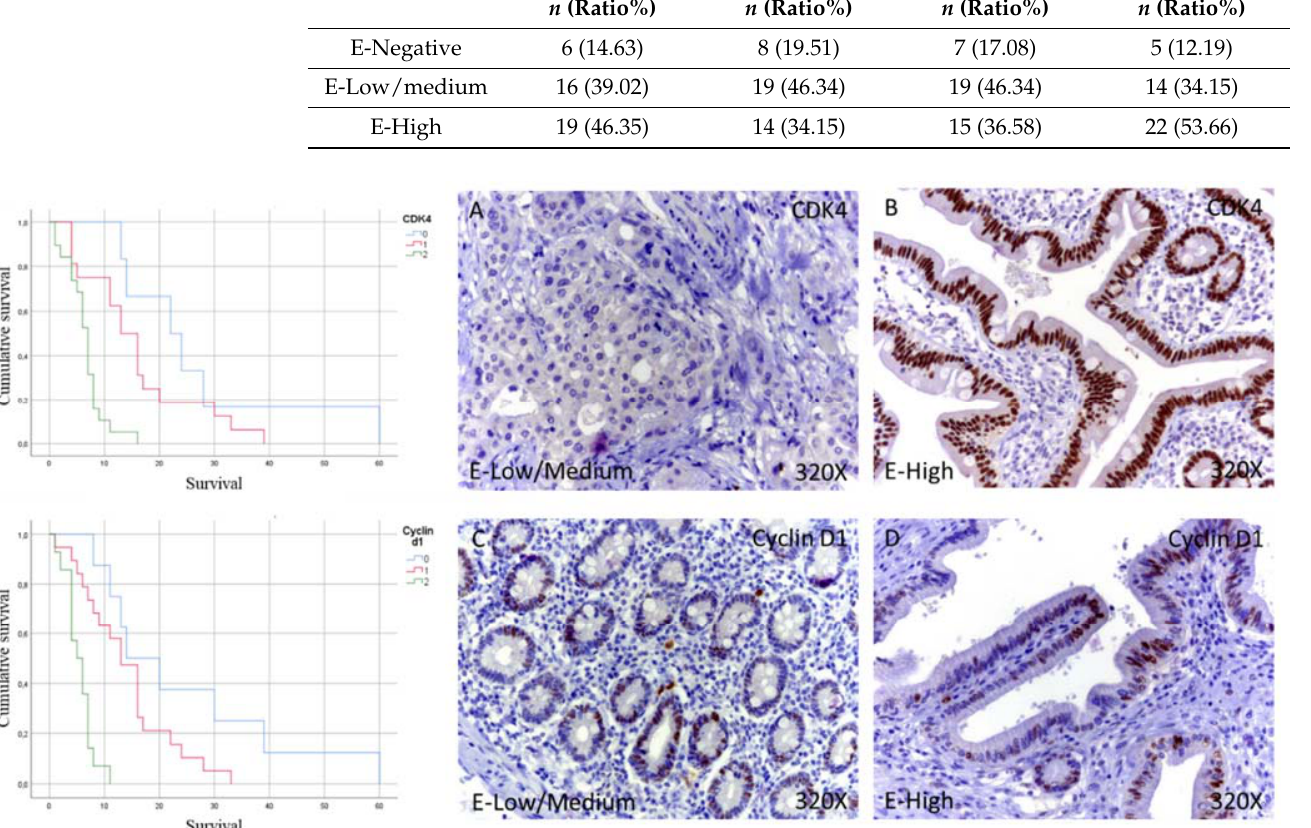
Figure 1. Kaplan–Meier curves for survival time according to tumor expression ( left ) and images showing the protein expression of CDK4 and Cyclin-D1 in patients diagnosed with pancreatic cancer ( right A – D ). E-Low/Medium = tissue expression classified as low/medium; E-High = tissue expression classified as high; 320 × magnification. Histological samples from patients diagnosed with pancreatic cancer were classified as negative expression (0), low/medium (1), and high (3) using the IRS Score method n = 41.